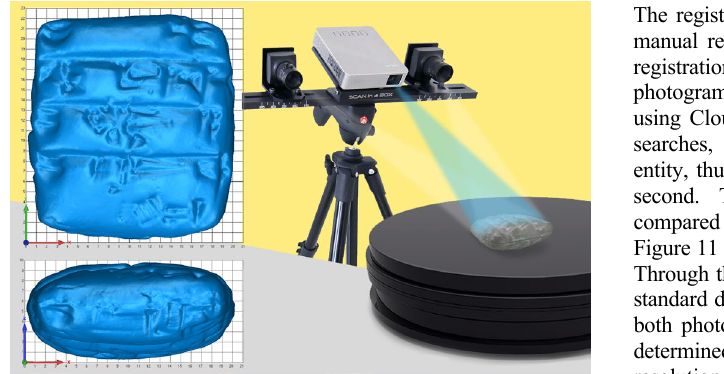
Figure 10 . “SCAN in a BOX” system and polygonal model of the tablet acquired (1mm grid